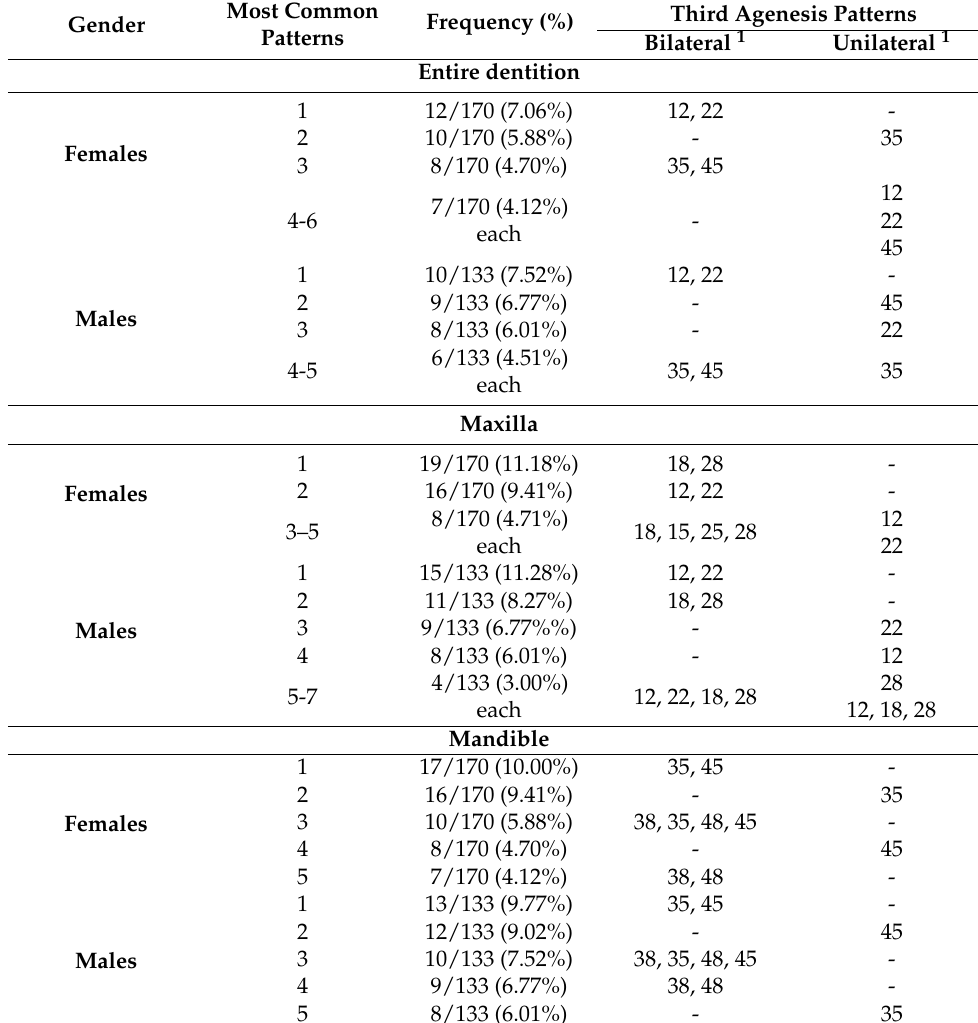
Table 4. The most common tooth agenesis patterns in individuals with agenesis of teeth other than the third molars when considering all the teeth in the